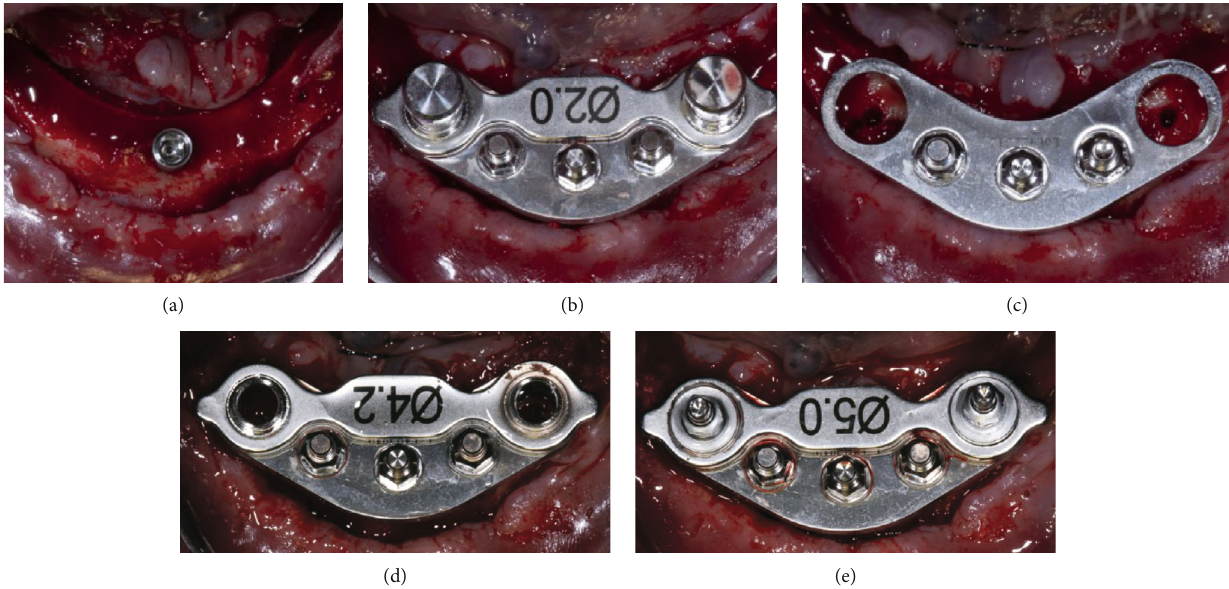
Figure 4: Intraoral view of the surgical steps (2): the fi rst surgical guide is removed (a) and the second is placed and fi xed (b, c), the distal implants sites are prepared thanks to metal bushings of increasing diameter (d), and the fi xtures are inserted